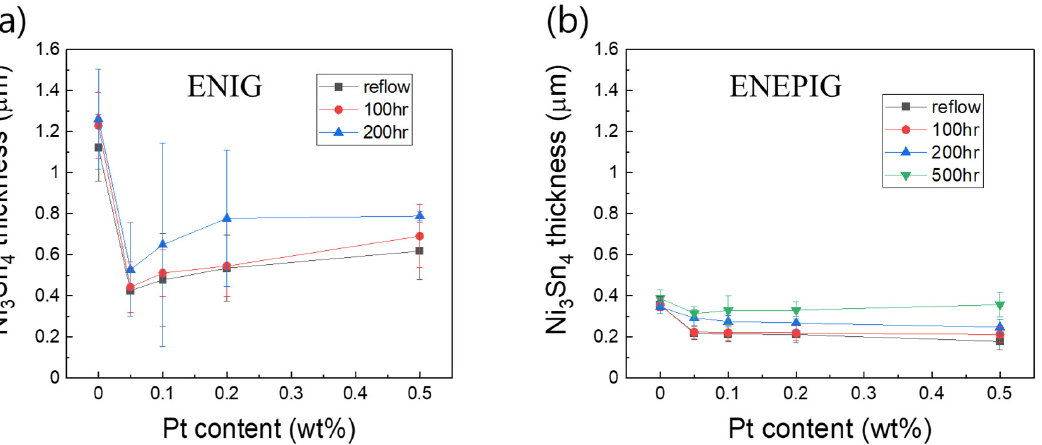
Figure 8. Thickness of Ni 3 Sn 4 IMCs formed at ( a ) Sn-58Bi-xPt/ENIG and ( b ) Sn-58Bi-xPt/ENEPIG interfaces.